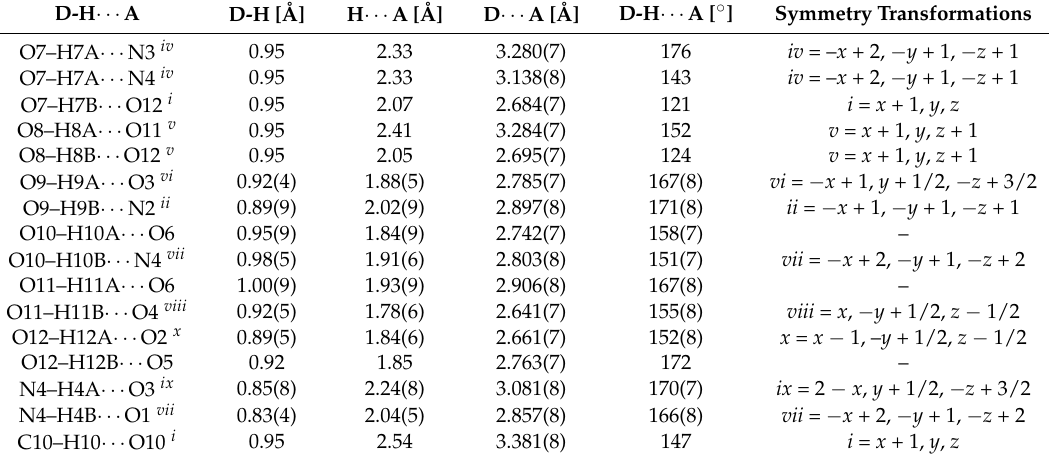
Table 2. Details of the hydrogen bonding interactions in 1 a